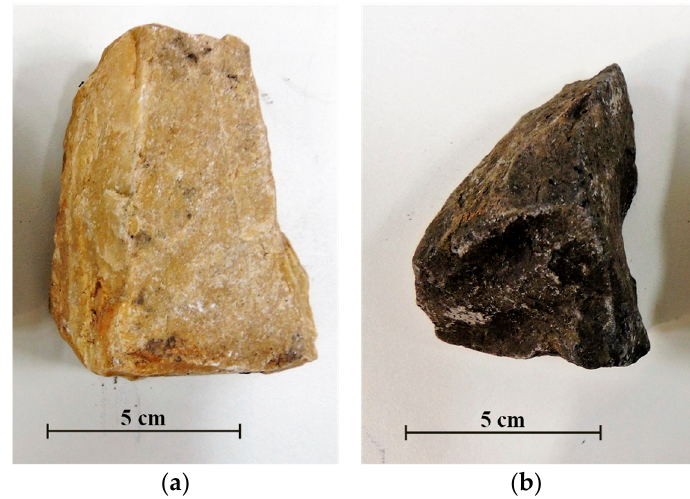
Figure 3. Quartzite rock fragment ( a ) and basalt rock fragment ( b ).